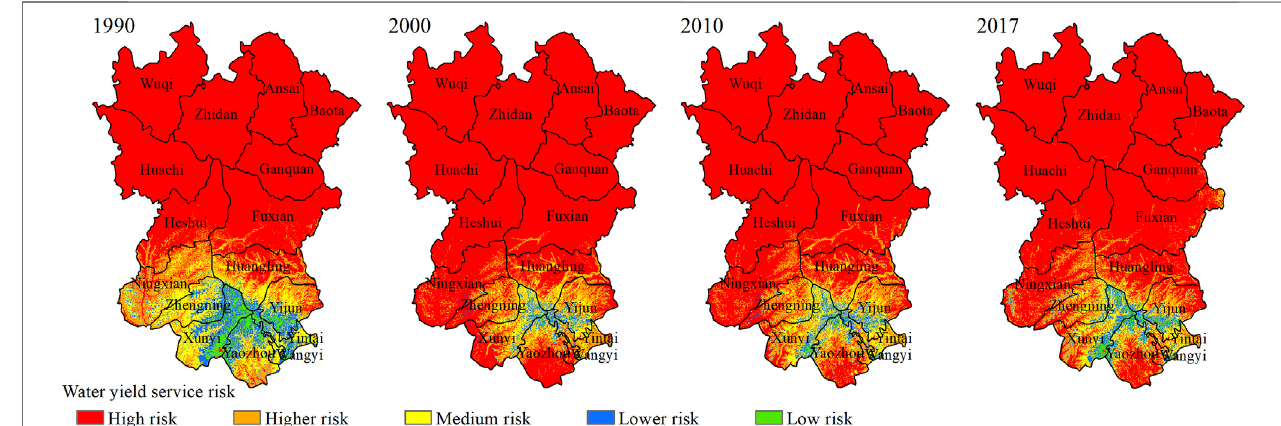
FIGURE 4 | Spatiotemporal variation in the water yield service risk in the ZMR from 1990 to 2017.